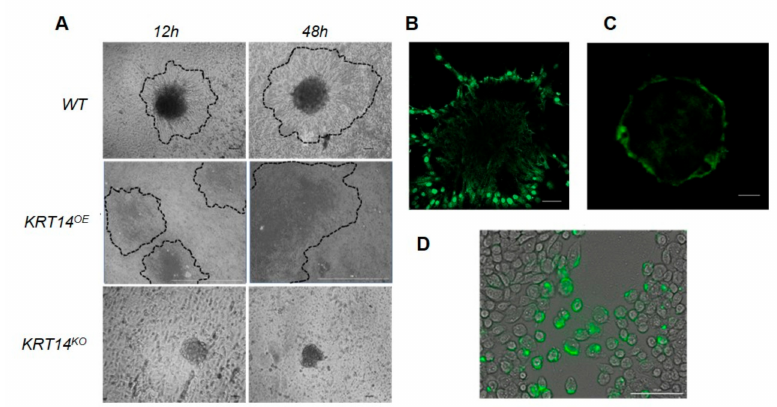
Figure5. ( A )Mesothelialdisplacementassays. Ovariancancerspheroidsweregeneratedfromwild-type (WT), KRT14 KO and KRT14 OE lines and overlaid onto a confluent layer of mesothelial cells and imaged by light microscope. Representative images following overnight and 48-h co-culture are presented where dotted lines indicate spheroid outgrowth and mesothelial displacement. ( B , C ) Embedding and outgrowth assays. OVCAR4 ovarian cancer spheroids were formed and overlaid into ( B ) Collagen I (24 h) or ( C ) Matrigel (48 h) samples, and subsequently fixed and stained for KRT14 expression. ( D ) Wound-healing assays OVCAR4 cells were grown as a monolayer, cells were wounded, fixed, and stained for KRT14 expression at time-points preceding total wound closure. Images from a representative well are shown with scale bars = 100 µ